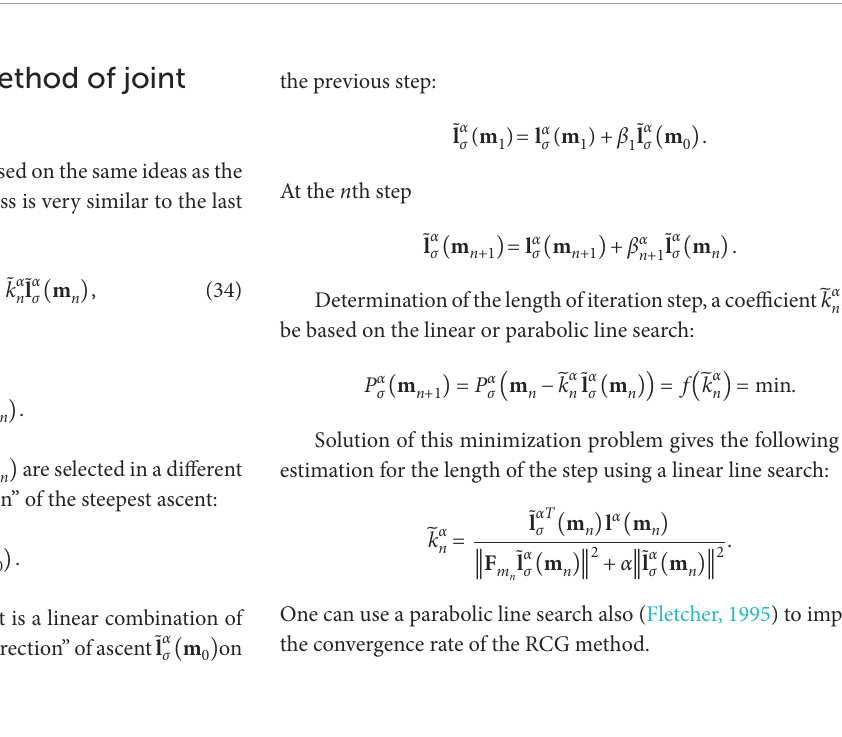
FIGURE 3 Observed and predicted data from standalone inversion. (A) Observed G zz data (left panel) and data predicted from standalone inversion of gravity gradiometry data (right panel). (B) Observed TMI data (left panel) and data predicted from standalone inversion of TMI data (right